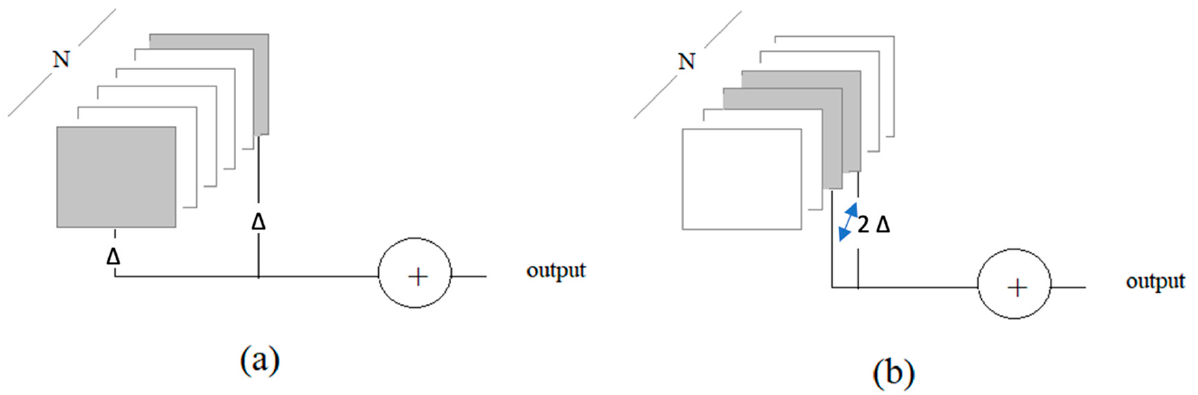
Figure 7. Frame selection approaches: ( a ) boundary test and ( b ) middle test.